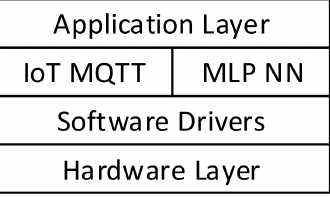
Figure 3. The layers stack for the proposed